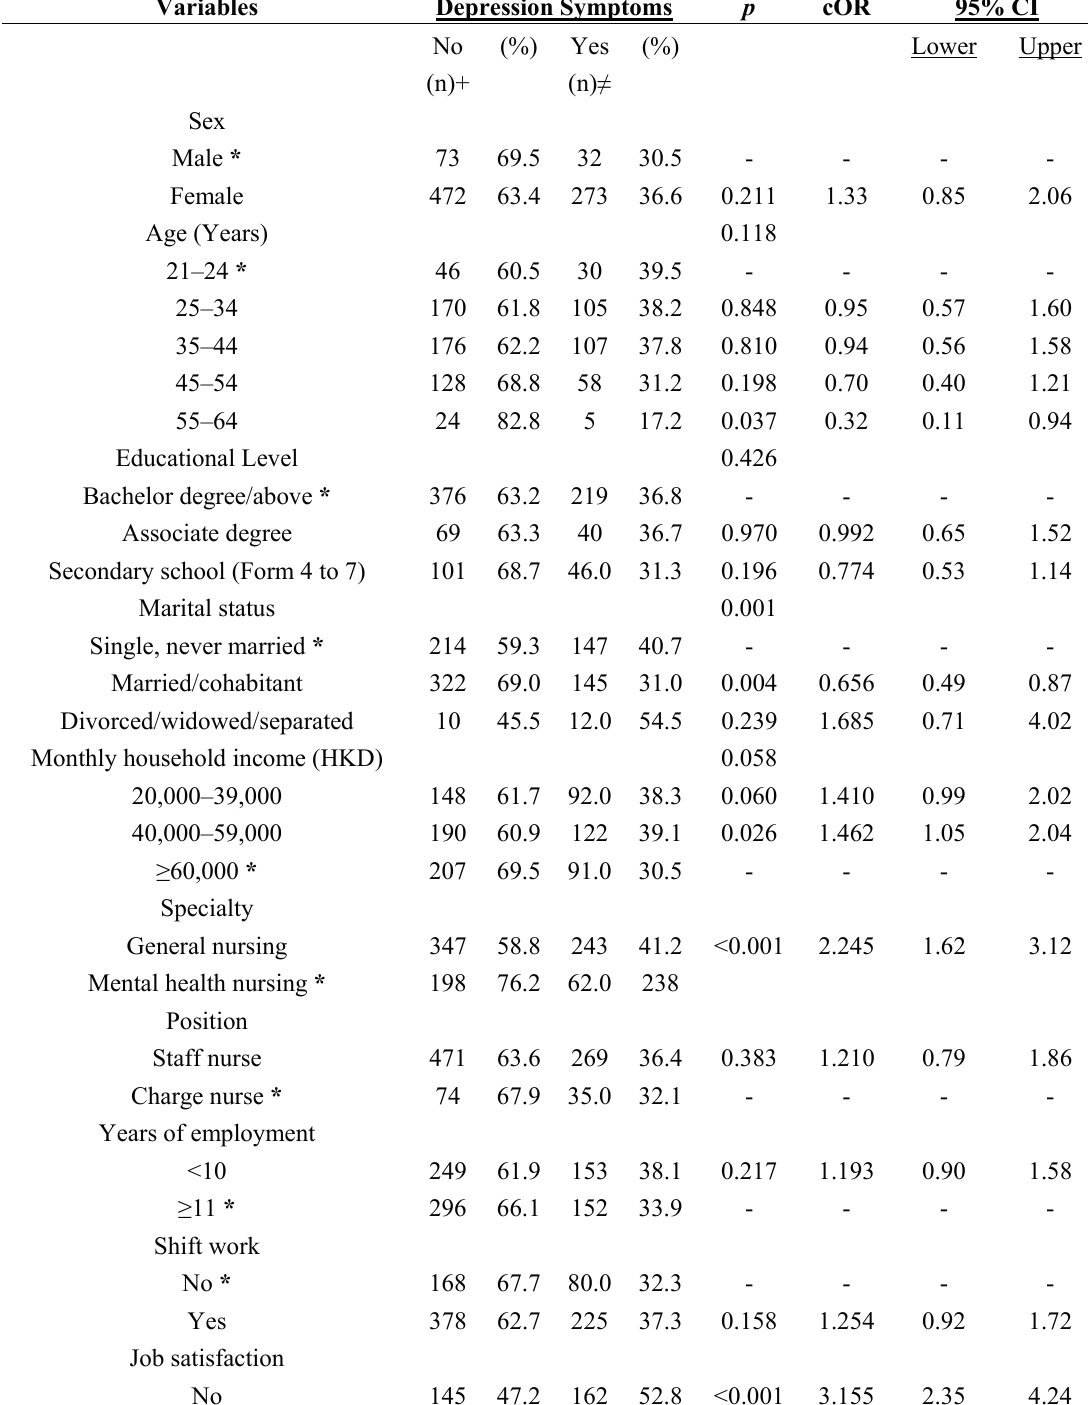
Table 2. Frequency distribution of respondents by depression status and socio-demographic characteristics and other selected